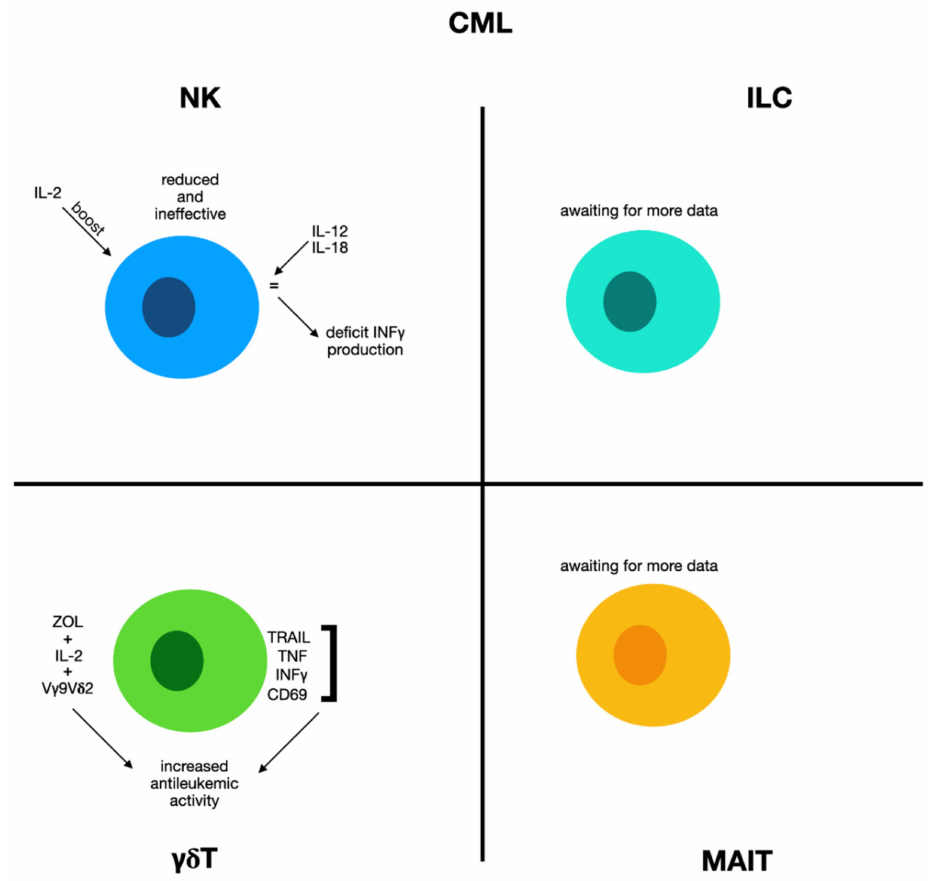
Figure 3. Chronic myeloid leukemia (CML) unconventional immune cell scenario. NK: NK cells are reduced and show alterations. IL-2 boost their activity. On the contrary, IL-12 and IL-18 diminish IFN- γ production. γδ T displayed an increased presence of CD69, IFN- γ , TNF, and TNF-related apoptosis-inducing ligand (TRAIL), a stimulated phenotype, with an increased antileukemic activity. Once administered, Vg9Vd2 cells, ZOL, and IL-2 provoked a reduction in the leukemic burden. NK cells can be active against a great group of hematological neoplasms comprising CML, and the rate and function of these immune effectors can be essential in the therapeutic response and prognosis of CML subjects [106,107]. In fact, an augmented